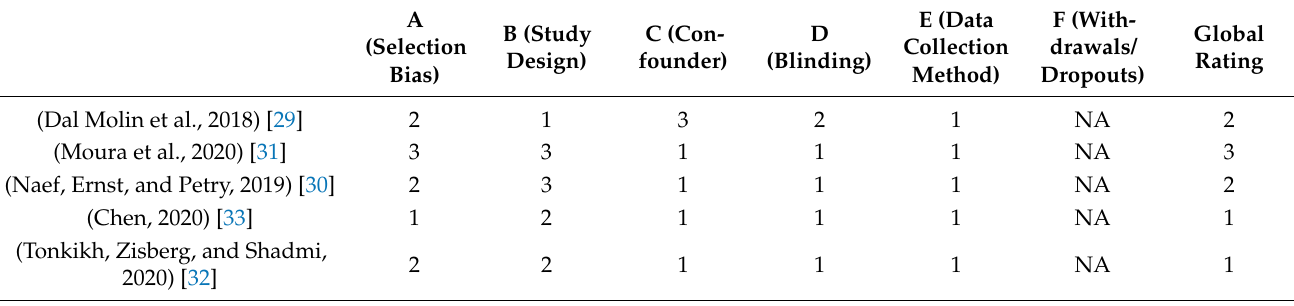
Table 2. Studies quality assessment